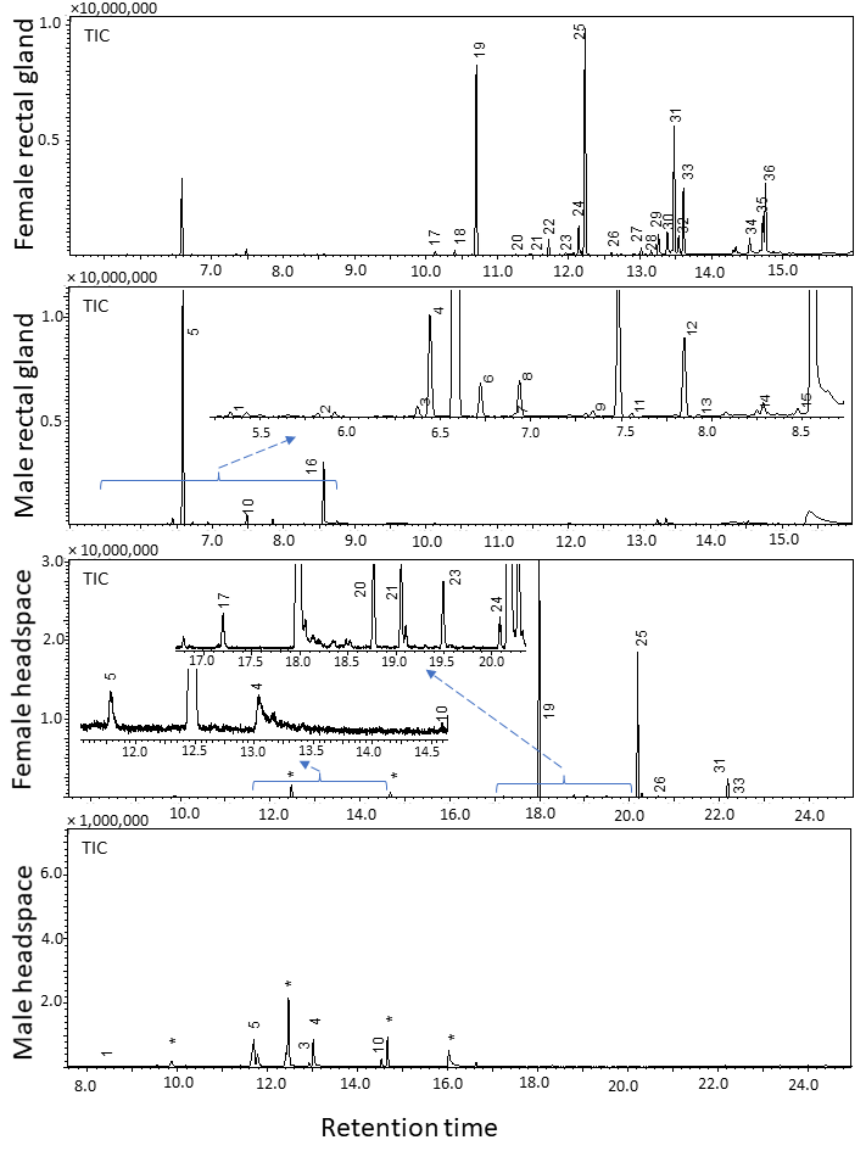
Figure 1. Chromatograms of rectal gland and headspace samples of B. kraussi females and males. Numbers represent compound number in Table 1; * indicates impurities identified by comparing with control samples or solvent runs.